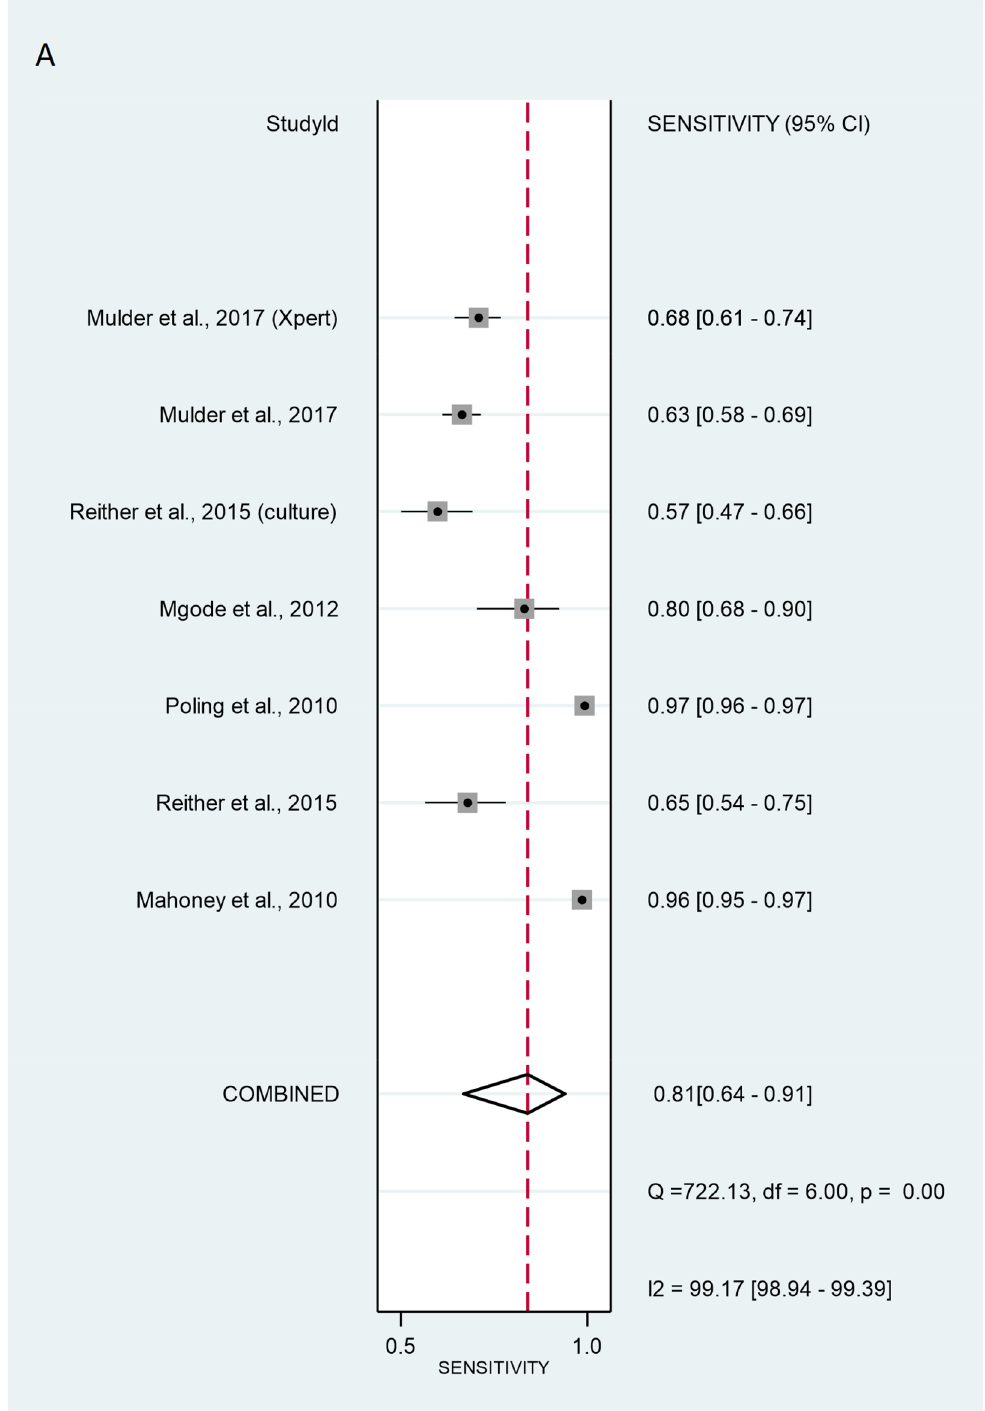
Figure 2. Sensitivity ( A ) and specificity ( B ) of individual studies are displayed by squares. The overall values are displayed by rhombus. Error bars indicate confidence interval of 95% [95% CI]. The reference method was Ziehl–Neelsen stain-based, direct microscopy, except for other method is indicated in